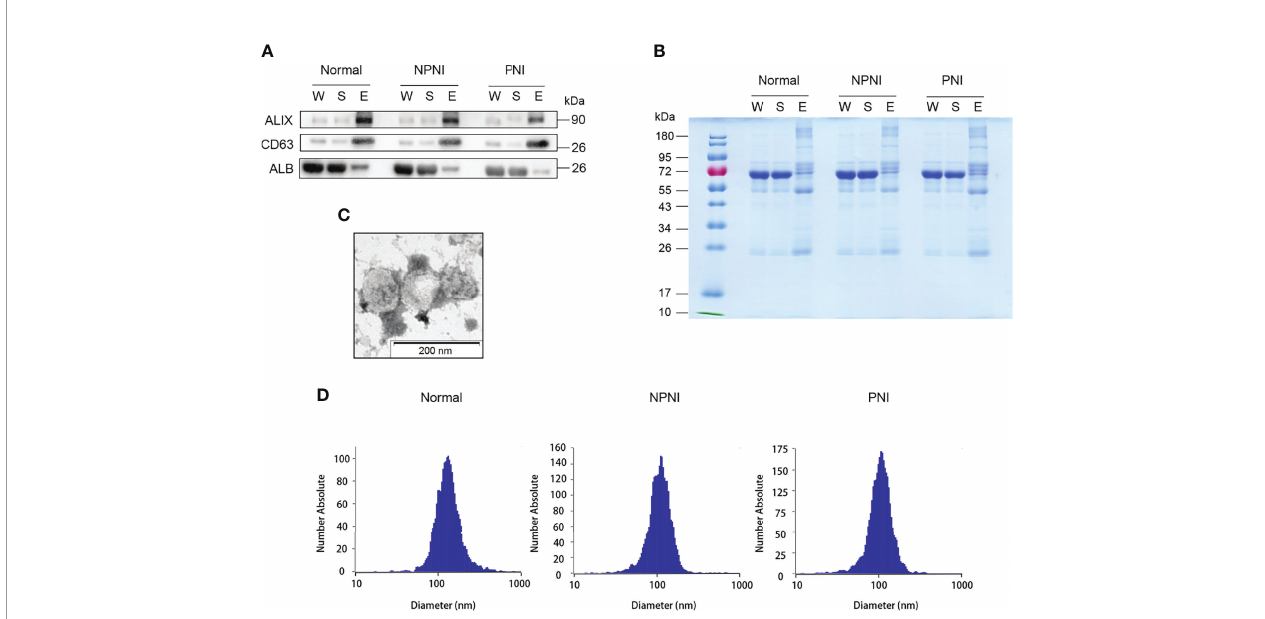
FIGURE 2 | Extracellular vesicle (EV) puri fi cation and identi fi cation. (A) Puri fi ed EVs were veri fi ed by Western blot detection of EV markers ALIX and CD63. (B) Equal amounts of proteins from each sample were loaded. (C) Transmission electron micrographs of EVs; scale bar: 200 nm. Coomassie Blue staining of the total proteins separated by SDS-PAGE. (D) Nanoparticle tracking analysis (NTA) analysis of the EVs from the healthy control, NPNI, and PNI groups.